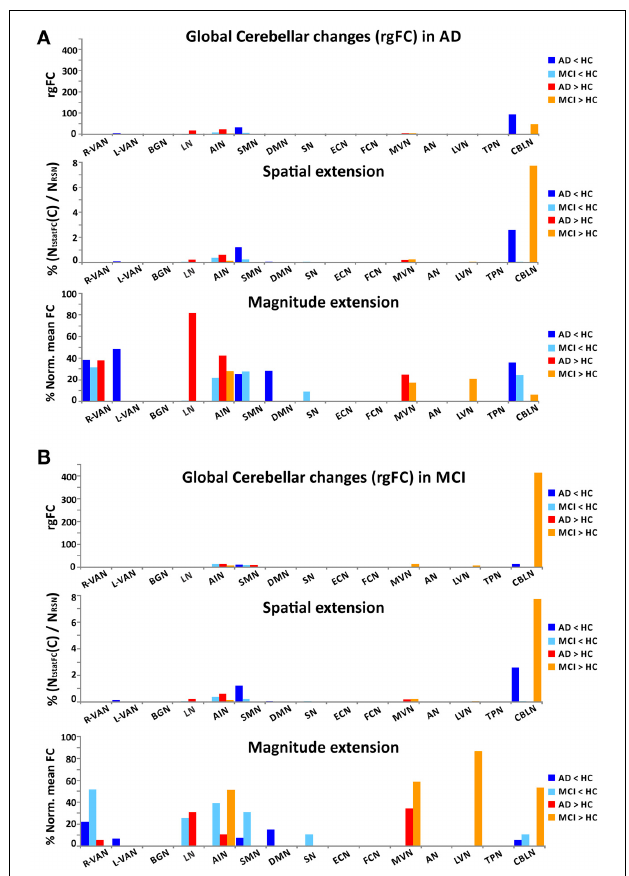
FIGURE 6 | Global cerebellar alterations in AD and MCI. For each RSNs and for each contrast (AD < HC, AD > HC, MCI < HC, and MCI > HC), the histograms show the global changes occurring in the cerebellum C(r gFC ) in AD (A) and in MCI (B) . For each RSN, the set of histograms shows: (1) the global changes of the r gFC index in the cerebellum (C), (2) the contribution to the r gFC in the cerebellum given by the spatial extension of the clusters of functional alteration ( N tstatFC / N RSN ), (3) the contribution of the magnitude extension of the cerebellar functional alteration [ meanFC (C) P with p = MCI or AD, normalized for the to the meanFC (C) HC